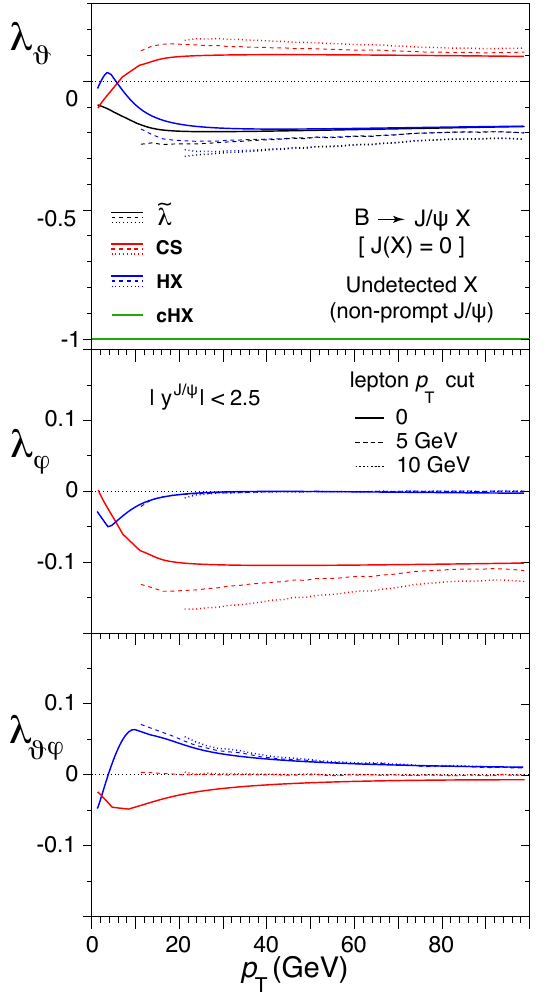
Figure 5 . The frame-dependent anisotropy parameters λ ϑ , λ ϕ , and λ ϑϕ (top to bottom rows), as well as the frame-invariant parameter ˜ λ (top row), of the dilepton decay distribution of inclusively observed non-prompt J /ψ mesons. The results are shown in the HX (blue) and CS (red) frames, as functions of the J /ψ p T , with no further selection (solid) and when minimum p T values are imposed on the decay muons (dashed and dotted). The green line represents the natural polarization of the generated events, λ ϑ = − 1